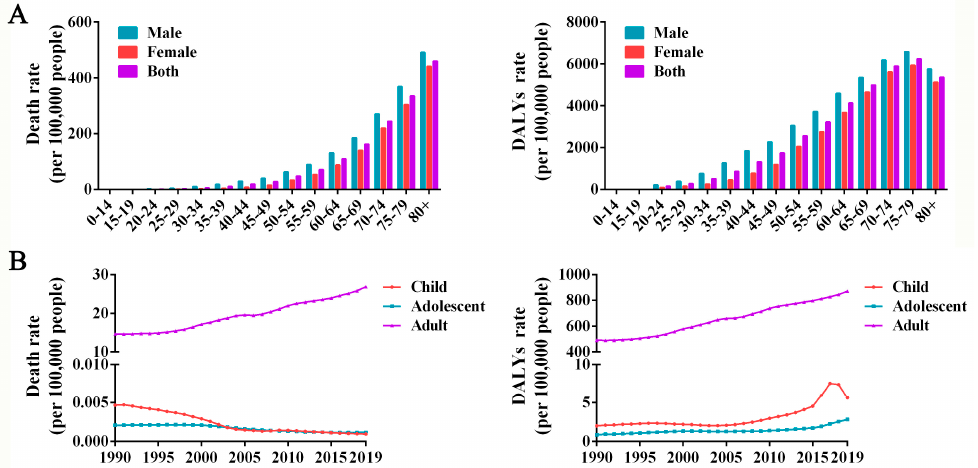
Figure 3. Burden of high BMI in various age groups in China. ( A ) The rate of deaths and DALYs in various age groups in China between 1990 and 2019. ( B ) The rate of deaths and DALYs in adults, children and adolescents between 1990 and 2019 in China.